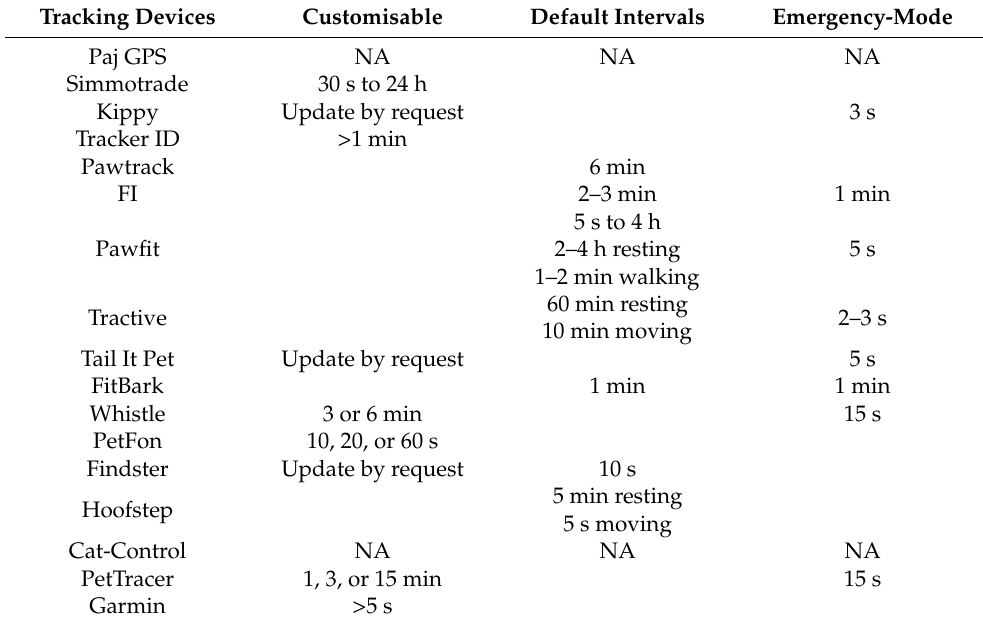
Table 9. Intervals for sending the tracking device position